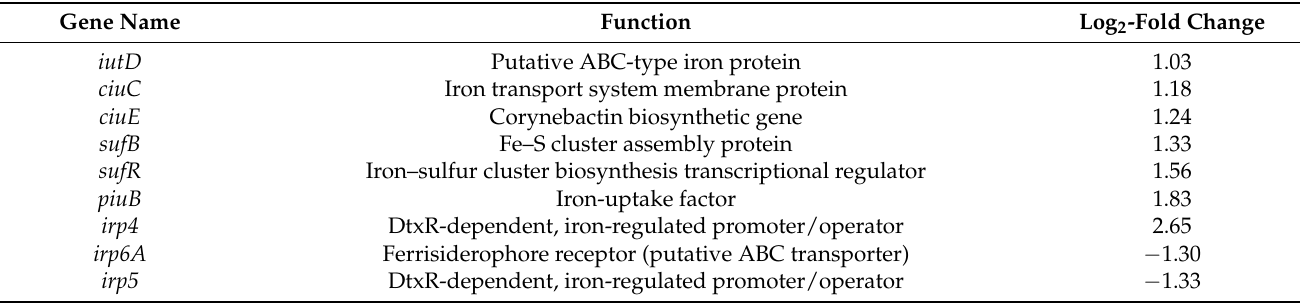
Table 2. Differential expression of representative genes involved in iron or heme transport in the ∆ rnj mutant determined by RNA-seq, using a 2-fold cutoff (log2-fold change of ±